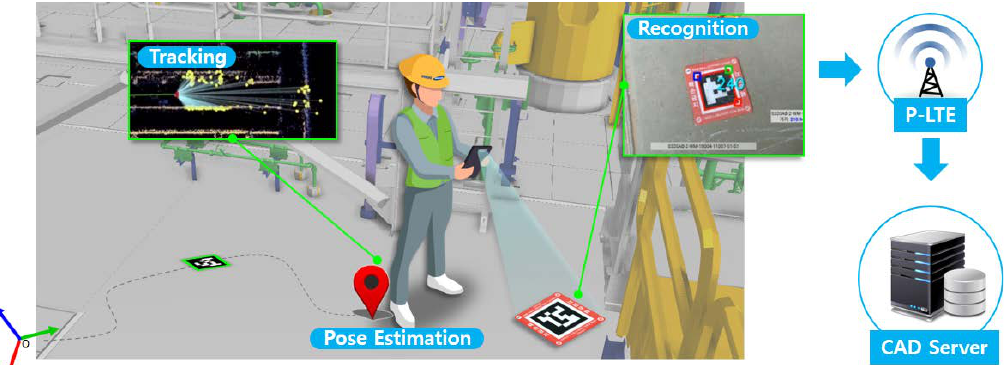
Figure 4. Concept of proposed automatic marker registration.